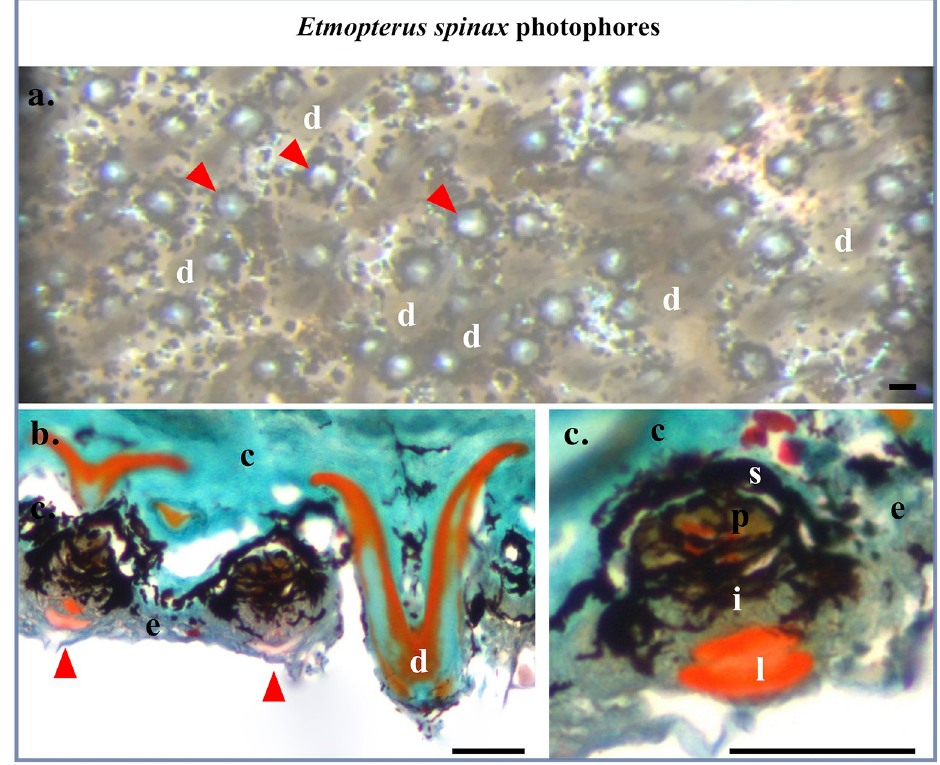
Fig 4. Etmopterus spinax photophore histology. (a). Binocular microscope view of the ventral skin of E . spinax , showing photophores (arrowhead). (b). Masson’s Trichrome staining colored section in the ventral skin of E . spinax showing photophores (arrowhead). (c) Close-up of the photophore in paraffin cross-section. c, connective tissue; e, epidermis; i, iris-like structure cells; l, lens cells; p, photocytes; s, pigmented sheath. Scale bars: 50 μ m.